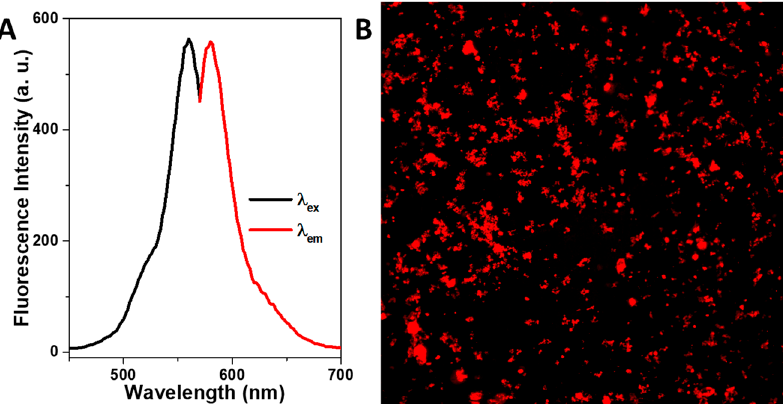
Figure 4. ( A ) Photoluminescence spectra and ( B ) confocal fluorescence images of HMMSN hybrid magnetic mesoporous nanorods.